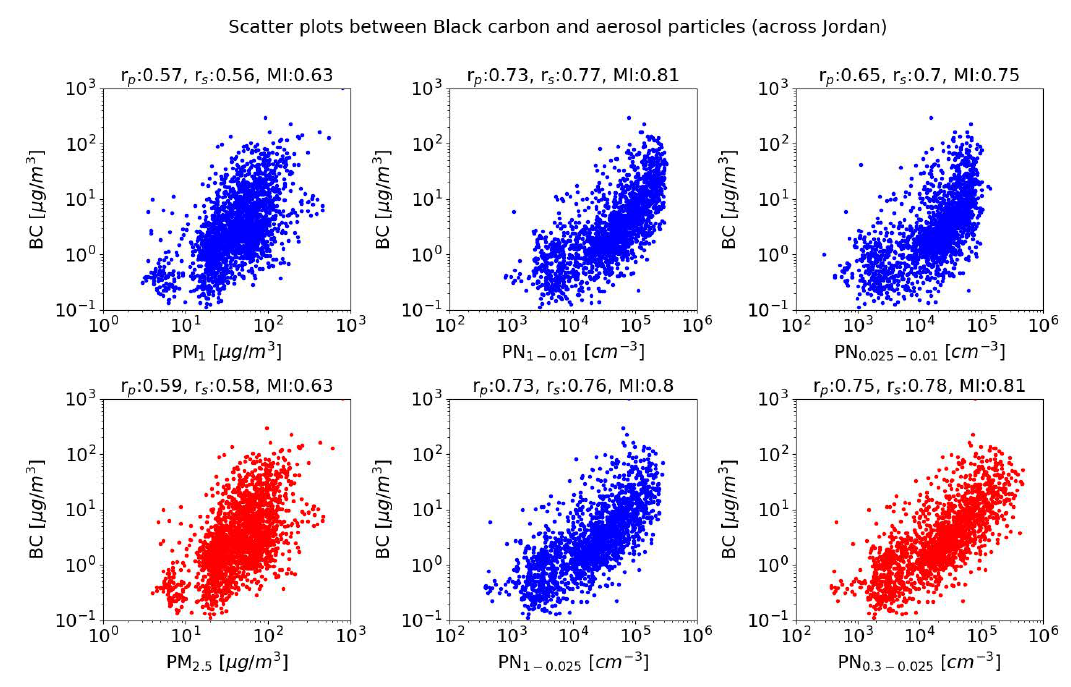
Figure 1. Scatter plots between black carbon (BC) mass concentrations and size-fractionated particulate matter (PM) mass/number concentrations measured throughout Jordan. Pearson (r p ) and Spearman (r s ) correlation coefficients and mutual information (MI) values are shown on the top of each subplot. The red data points represent the used features for the BC proxies’ inputs whereas the blue data points indicate the remaining unused